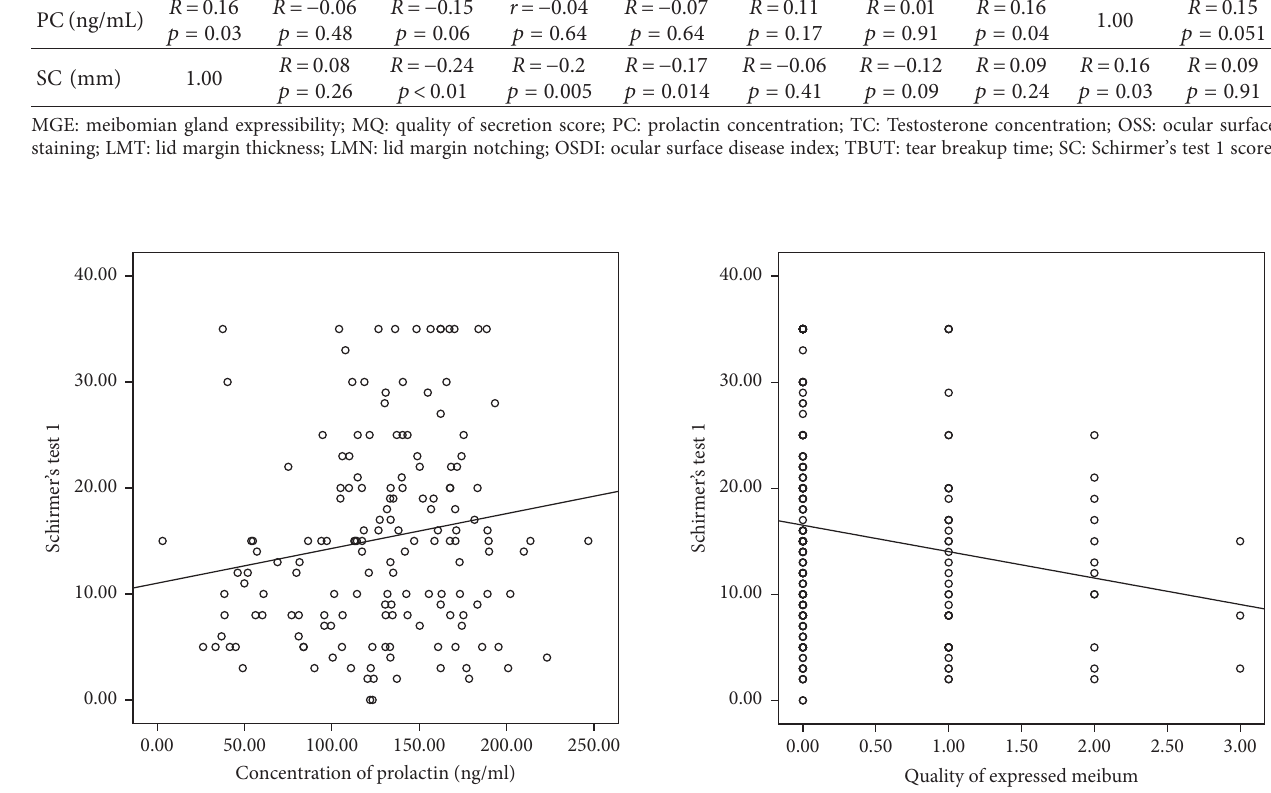
Figure 1: Correlation between prolactin and Schirmer’s test score. Figure 3: Correlation between Schirmer’s test 1 and the quality of expressed meibum.